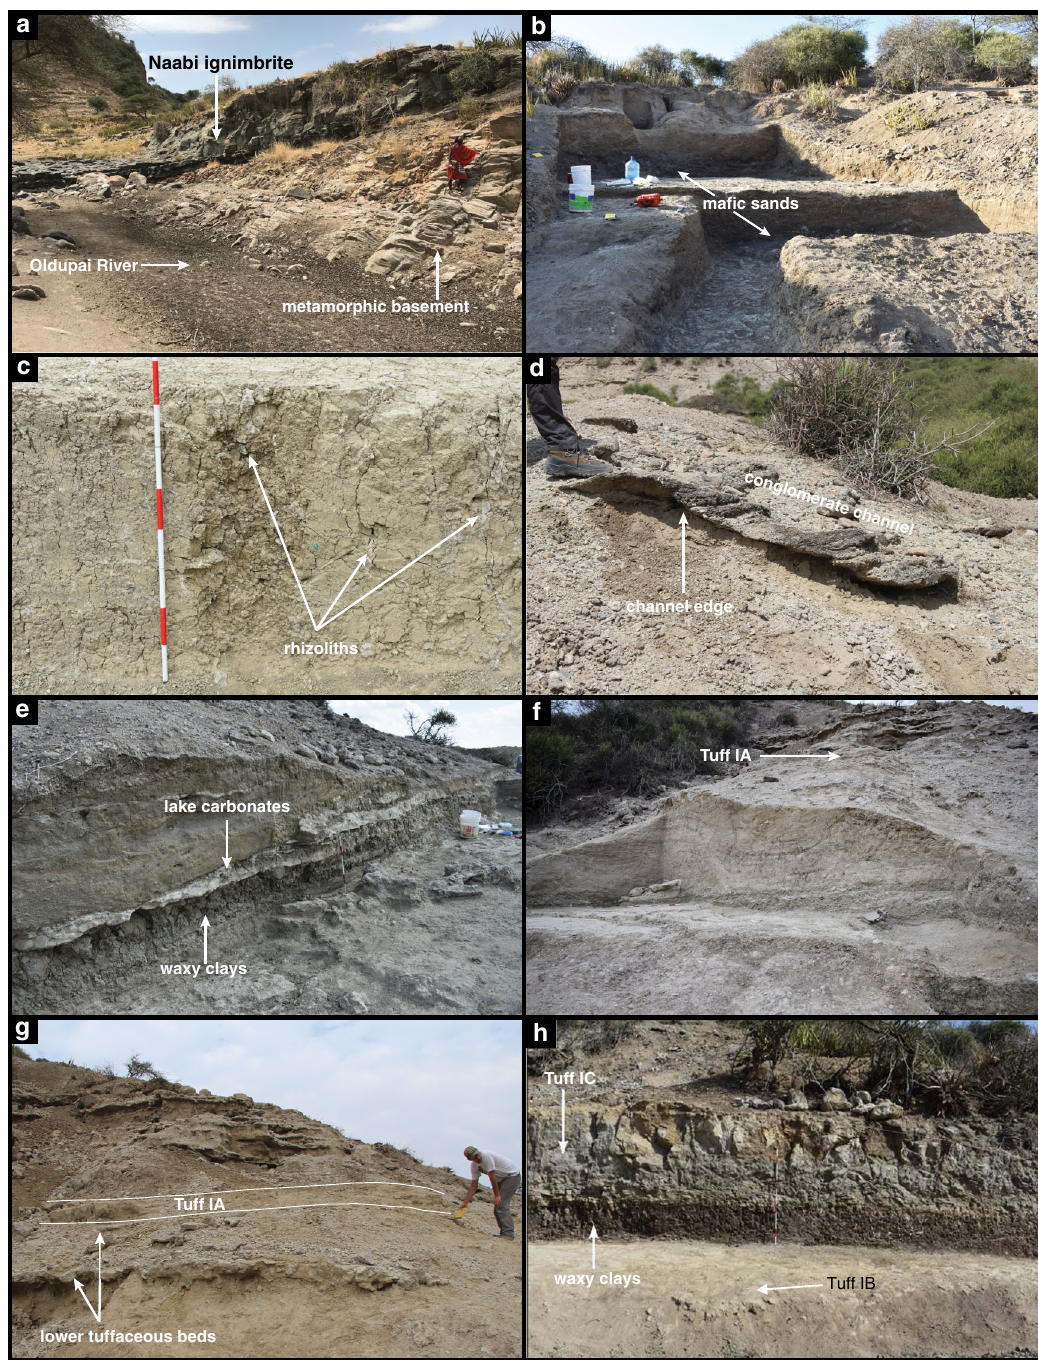
Fig. 2 Key stratigraphic horizons. a Ngorongoro formation: Naabi ignimbrite overlying metamorphic basement along the Oldupai River. b Ngorongoro Formation: Ma fi c sands immediately above the Naabi in trench 7. c Ngorongoro formation: CFCT compositional zone, trench 5, characterized by abundant rhizoliths. d Lower Bed I: conglomeratic channel fi ll deposit with trough-cross strati fi cation dipping to the east. e Lower Bed I: waxy claystones from trench 3 capped by carbonate beds. f Lower Bed I: multi-storey fl uvial channel belt deposits in trench 2, several meters beneath Tuff IA. (Metric pole on the ground for scale.) g Lower Bed I: Ewass Oldupa exposure of Tuff IA and underlying thin tuffaceous beds. h Upper Bed I: thick waxy claystone unit capping Tuff IB, and underlying Tuff IC. See Fig. 5 for further stratigraphic